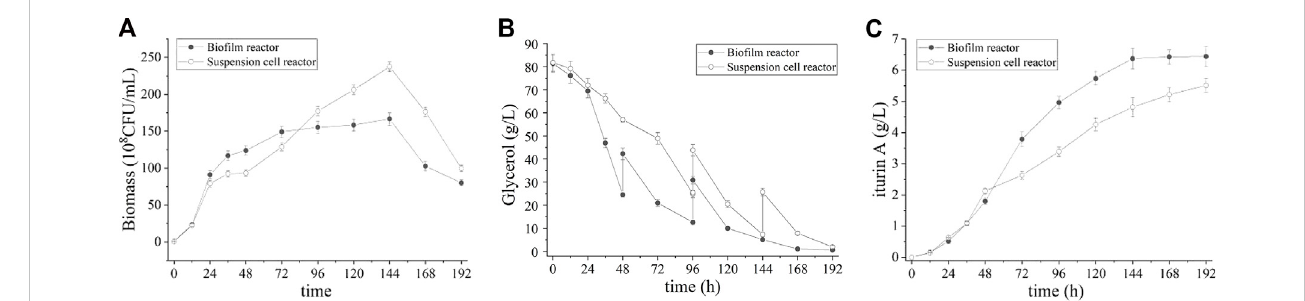
FIGURE 4 Time course of biomass (A) , residual glycerol (B) and iturin A production (C) during the fed-batch fermentation in suspension cell reactor and bio fi lm reactor.